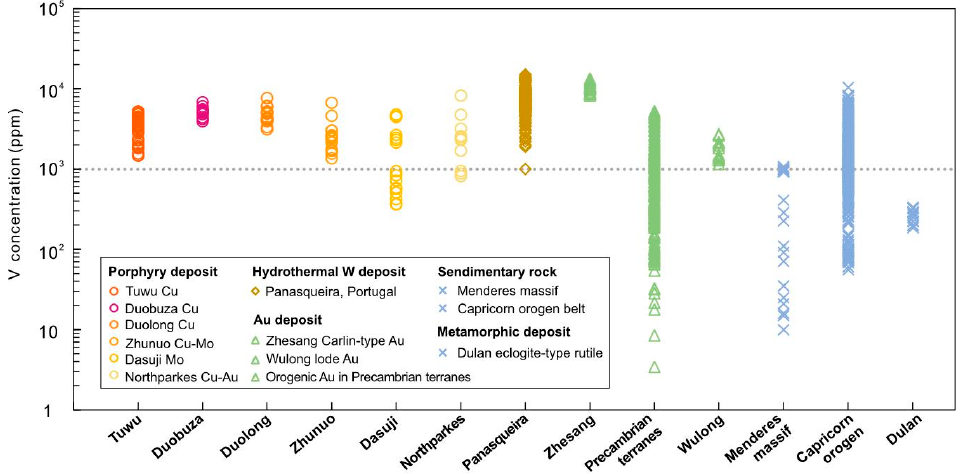
Figure 10. Vanadium contents of rutile of the Tuwu porphyry copper deposit compared with several other deposits. The compiled porphyry deposits include Duobuza Cu [12], Duolong Cu [93], Zhunuo Cu - Mo [20], Dasuji Mo [94], and Northparkes Cu-Au [11]. The hydrothermal W deposit includes the Panasqueira deposit in Portugal [17]. The Au deposits include the Zhesang Carlin-type Au [6], the orogenic Au deposit in Precambrian terranes [7], and the Wulong lode Au [68]. Data from sedimentary rocks are from Menderes massif [70] and Capricorn orogen belt [95]. The